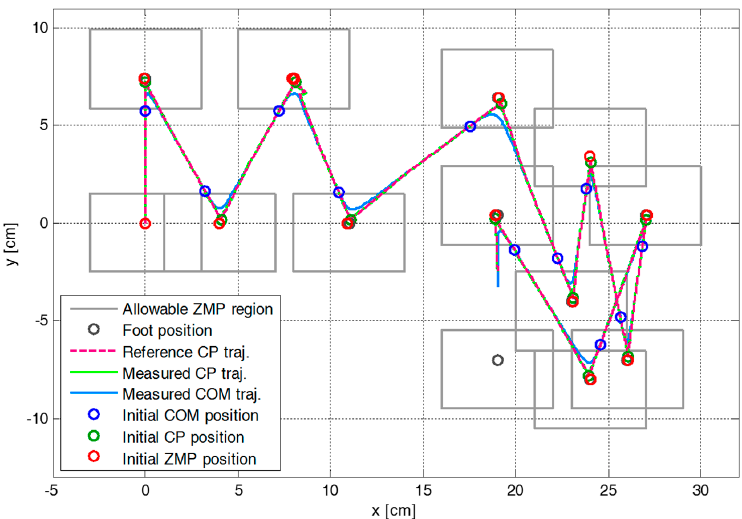
Figure 6. Reference CP trajectory, 𝛏 (cid:3045)(cid:3032)(cid:3033) , generated through ZMP manipulation, as well as measured CP and COM trajectories, 𝛏 (cid:3030) and 𝐱 (cid:3030) , for the modifiable walking pattern in the first simulation.